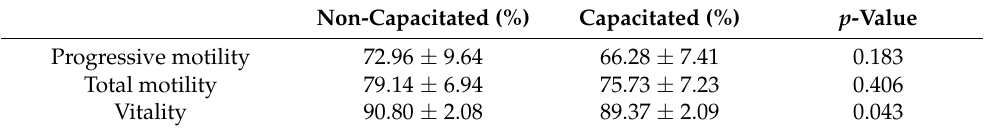
Table 1. Comparison of sperm parameters between non-capacitated and capacitated spermatozoa.